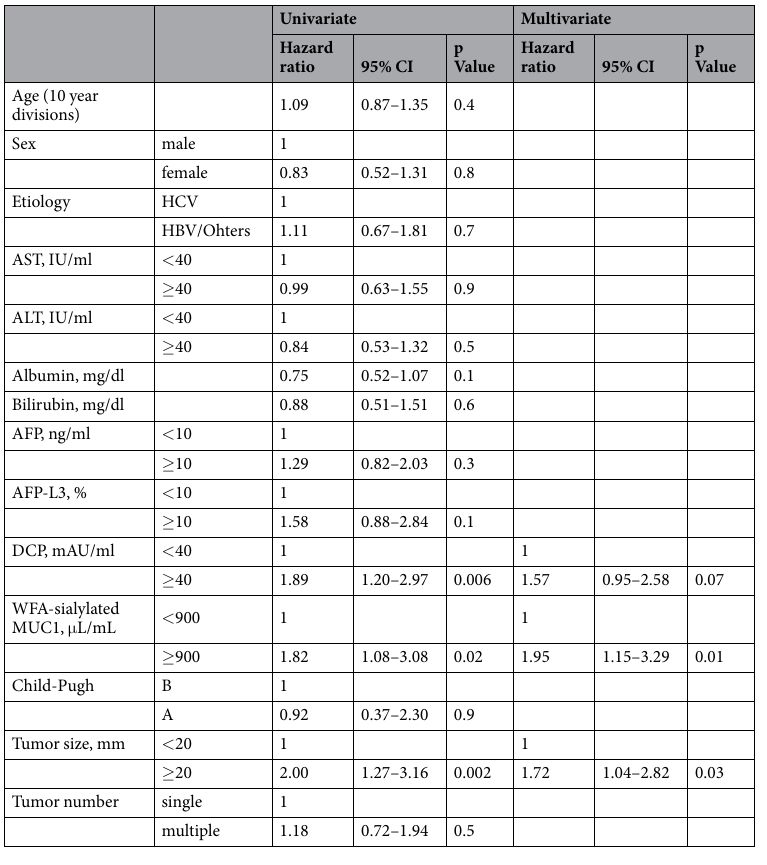
Table 3. Factors associated with HCC